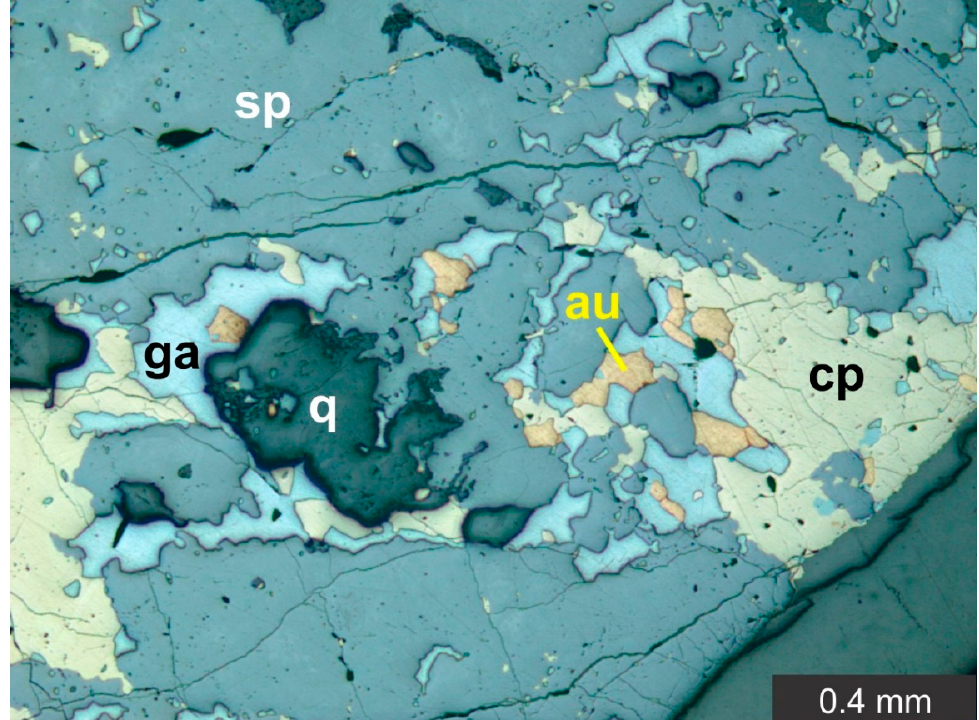
Figure 3. Photomicrograph showing an anastomosing veinlet, contiguous with the veinlet in Figure 4, illustrating the crosscutting relationships between the later veinlet chalcopyrite (cp), galena (ga), gold (au), and quartz (q), and the primary VMS mineralization locally dominated by sphalerite (sp). Sample RG14-21B.